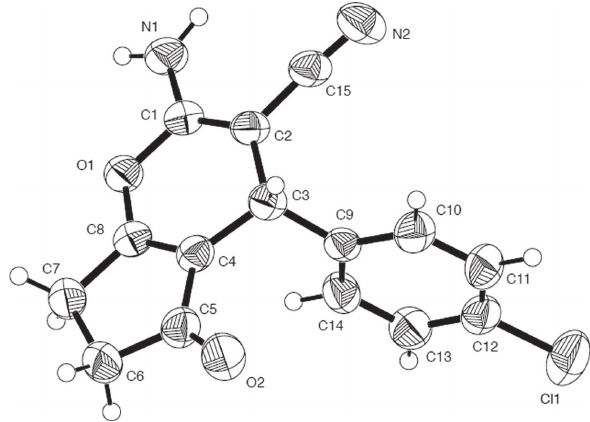
Table 2: Fractional atomic coordinates and isotropic or equivalent isotropic displacement parameters (Å 2